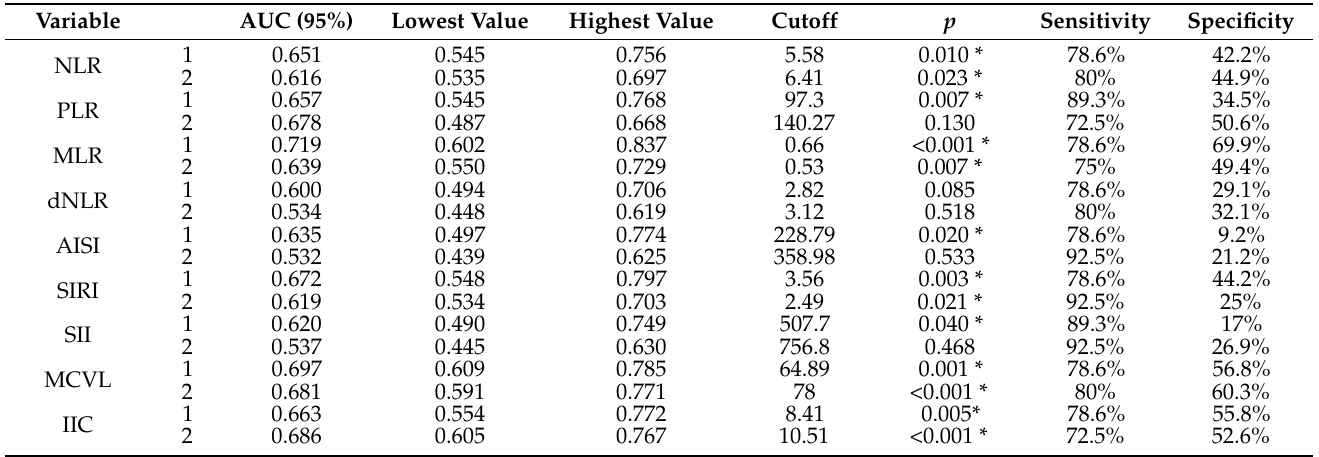
Table 7. Cutoff values of laboratory parameters for determining the risk of complications with surgical risk in the pre-COVID (1) and peri-COVID (2) groups.